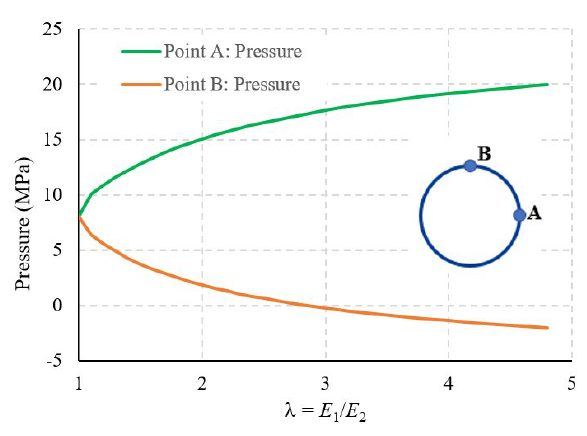
Fig. 8. Pore pressure at two points ( θ = 0 or π ) and B ( θ = π /2 or 3 π